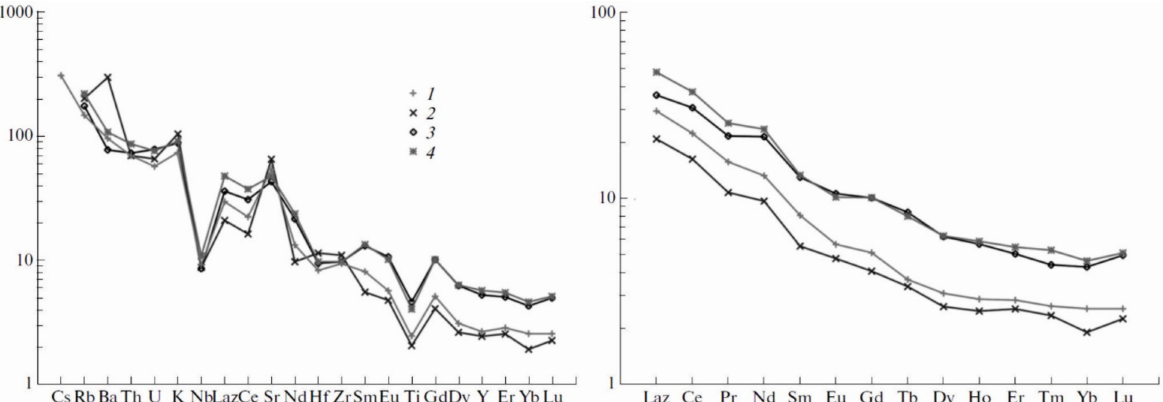
Figure 11. Multicomponent diagrams for magmatic rocks of the Lazurnoe deposit, normalized to the primitive mantle (after [31]). 1 and 2—adakitic monzodiorites from the South Stock; 3 and 4—gabbro-monzodiorites from the North